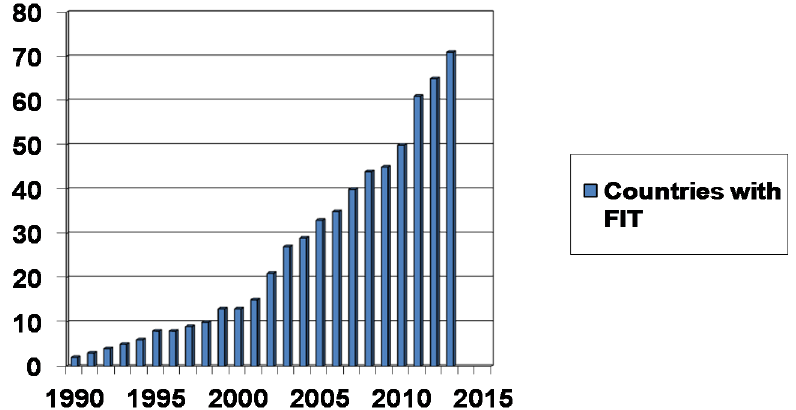
Figure 4. International diffusion of feed-in tariffs 1990–early 2013 (data basis